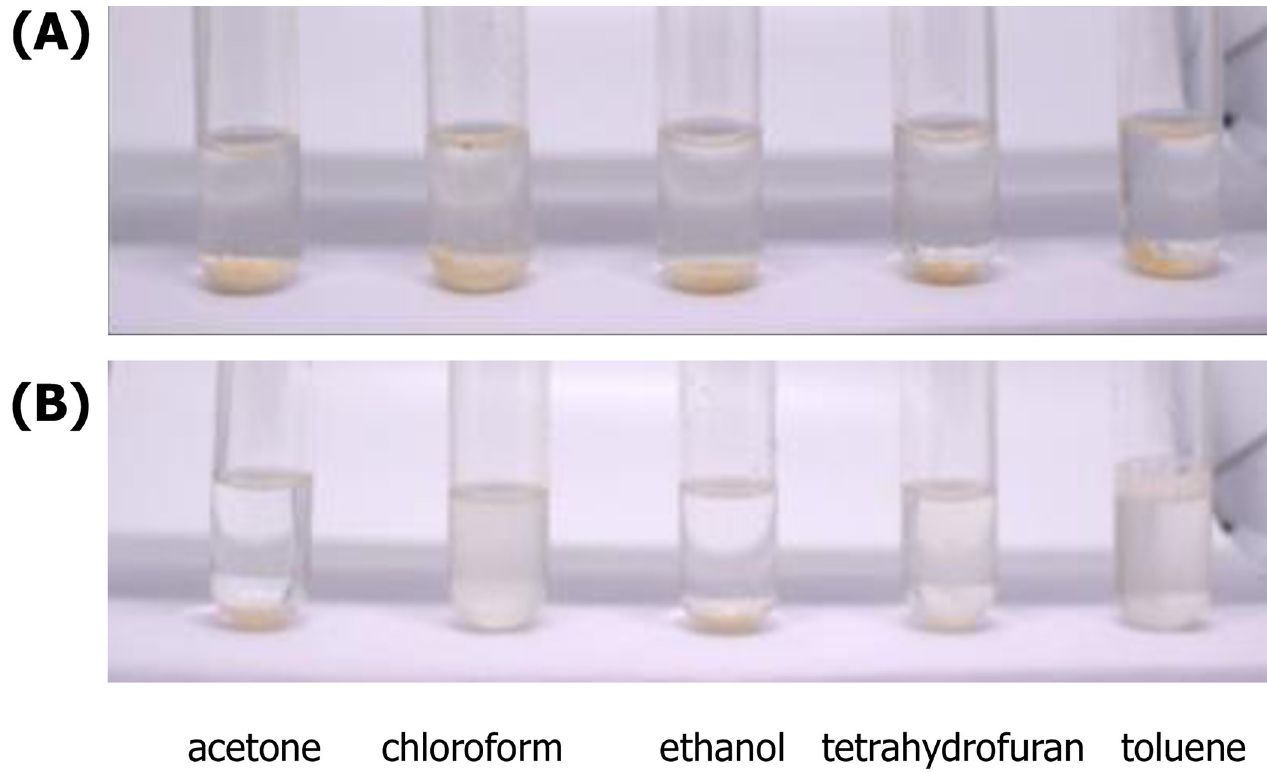
Fig 4. Comparison of solubility tests in acetone, chloroform, ethanol, tetrahydrofuran and toluene for (A) native PALF-MCC and (B) esterified PALF-MCC laurate.